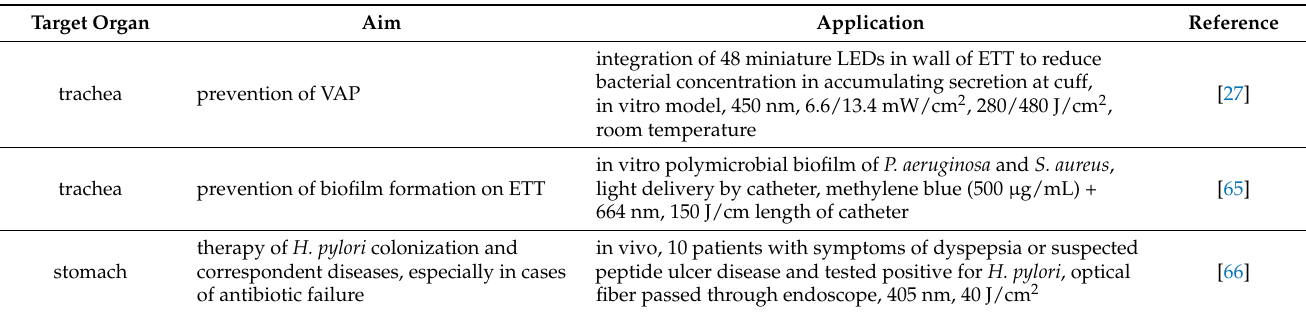
Table 2. Visible light-based approaches for intended application inside the human